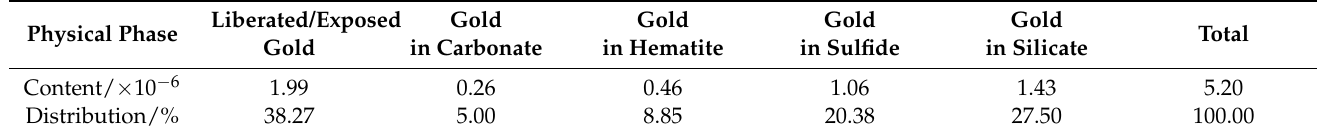
Table 2. Chemical phase analysis of gold in the raw ore.